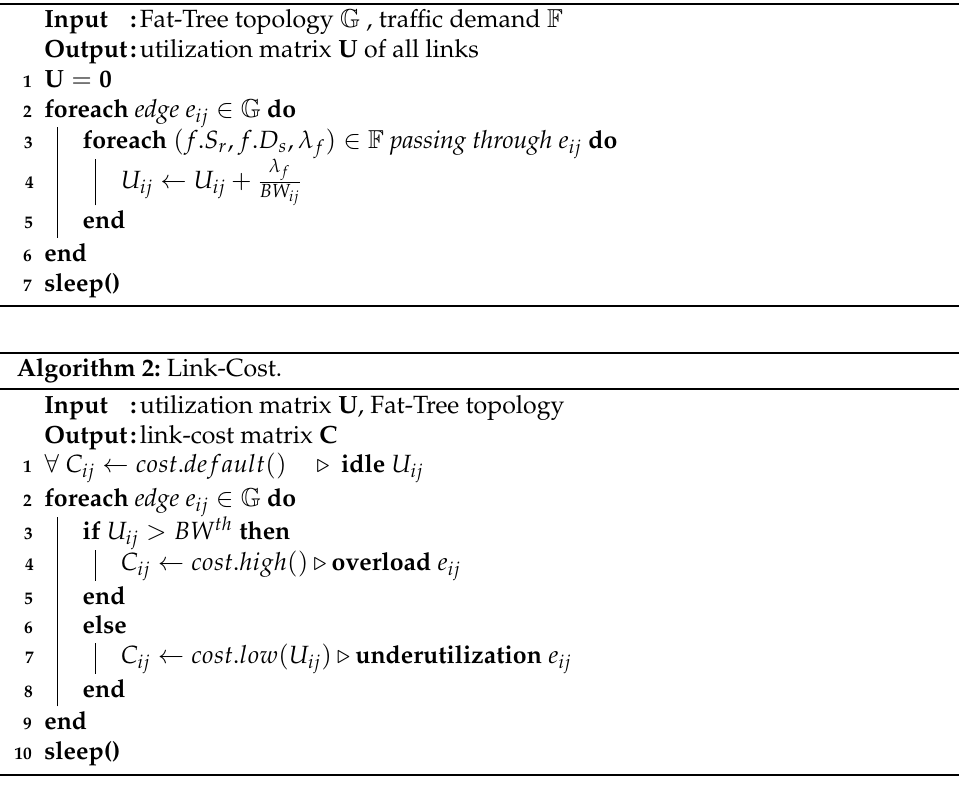
Algorithm 1: Link-Utility.